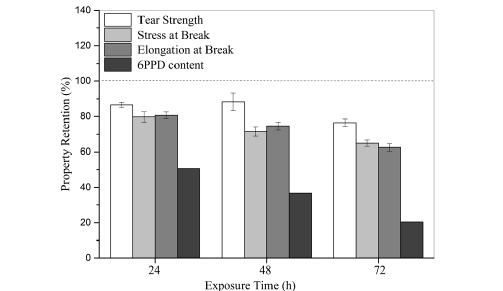
Figure 15. Retention of properties in oven thermo-oxidative aging of the composition comprising 2.5 phr of 6PPD and 1.0 phr of TMQ.